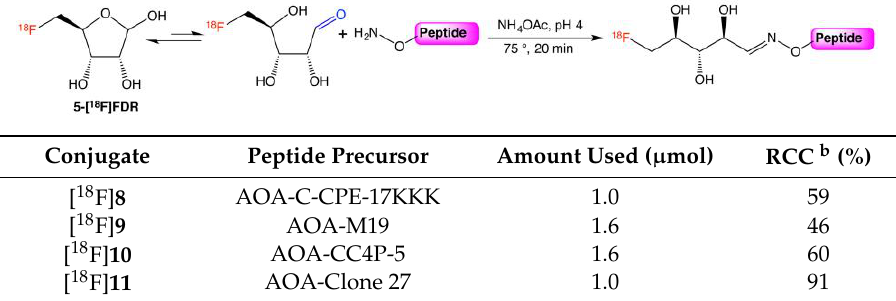
Conjugate Peptide Precursor